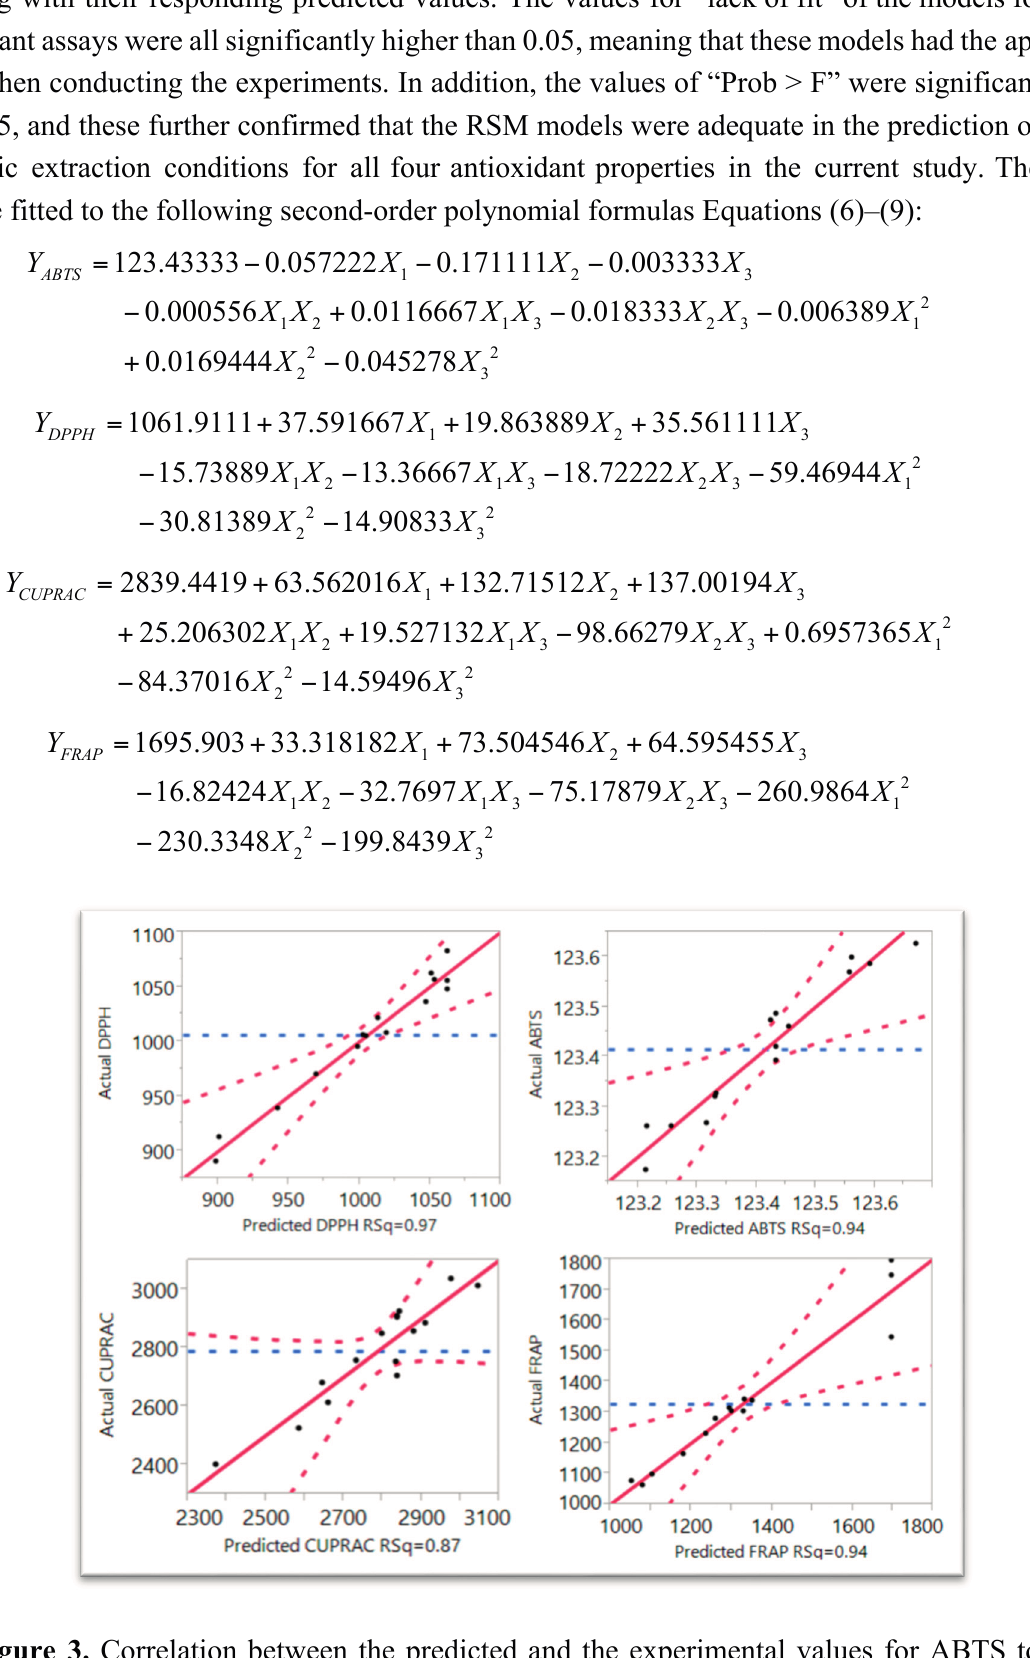
Figure 3. Correlation between the predicted and the experimental values for ABTS total antioxidant capacity, DPPH free radical scavenging capacity, cupric reducing antioxidant power (CUPRAC) and ferric reducing antioxidant power